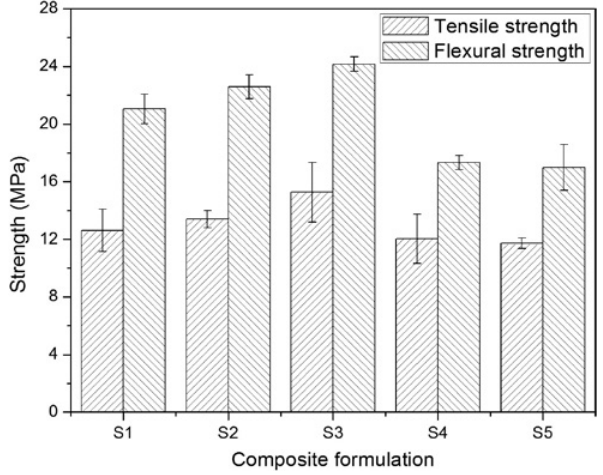
Figure 4: Tensile and flexural strength of the